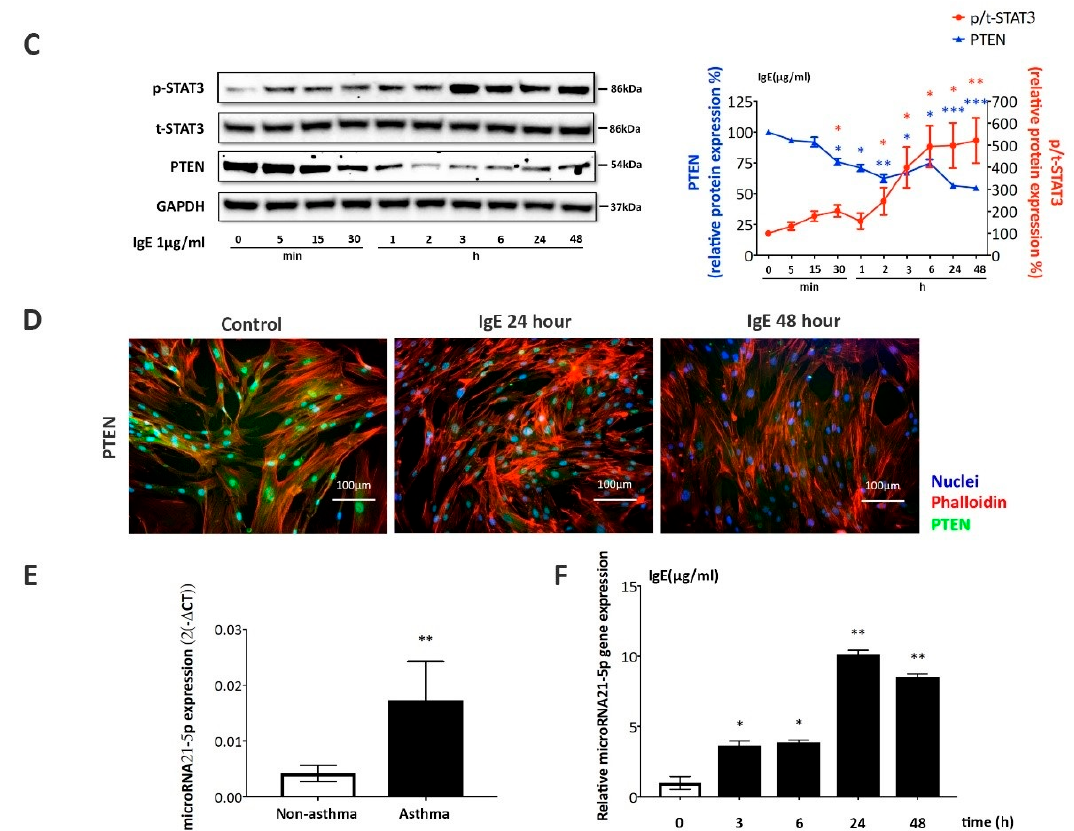
Figure 4. IgE activated PI3K → AKT → mTOR and STAT3 → microRNA-21-5p, down-regulating PTEN in ASMC. ( A ) Representative Western blot kinetic of IgE-induced PI3K, AKT, and P70S6K phosphorylation in ASMC, and quantitative analysis of all five blots by Image J (line chart). Data points represent mean ± SEM experiments performed in ASMC of five asthma patients. * p < 0.05, ** p < 0.01. ( B ) Representative immunofluorescence microscopy of IgE (1 µ g/mL) induced PI3K phosphorylation (upper panel, green) at 30 min and 1 h, and mTOR phosphorylation (lower panel, green-turquois) accumulation in the nuclei at 24 and 48 h. (nuclei: blue, F-actin: red). ( C ) Representative Western blots (right panel) and quantitation analysis by image J (left panel) of STAT3 phosphorylation and PTEN expression in response to IgE (1 µ g/mL). Data points represent mean ± SEM of repeated measurements in ASMC of five asthma patients. * p < 0.05, ** p < 0.01, *** p < 0.001. ( D ) Representative immunofluorescence images of PTEN (green-turquois) expression in the presence of IgE. F-actin is indicated by TRIC-Phalloidin (red) and nuclei by DAPI (blue). ( E ) Real-time PCR analysis of microRNA-21-5p expression in ASMC of five asthma patients and non-asthma controls ( n = 5). * p < 0.05. ( F ) Kinetic of microRNA-21-5p expression by Real-time PCR. Bars show mean ± SEM of experiments performed in ASMC of five asthma patients. MicroRNA-21-5p expression at time 0 was set as 1. * p < 0.05. ** p <